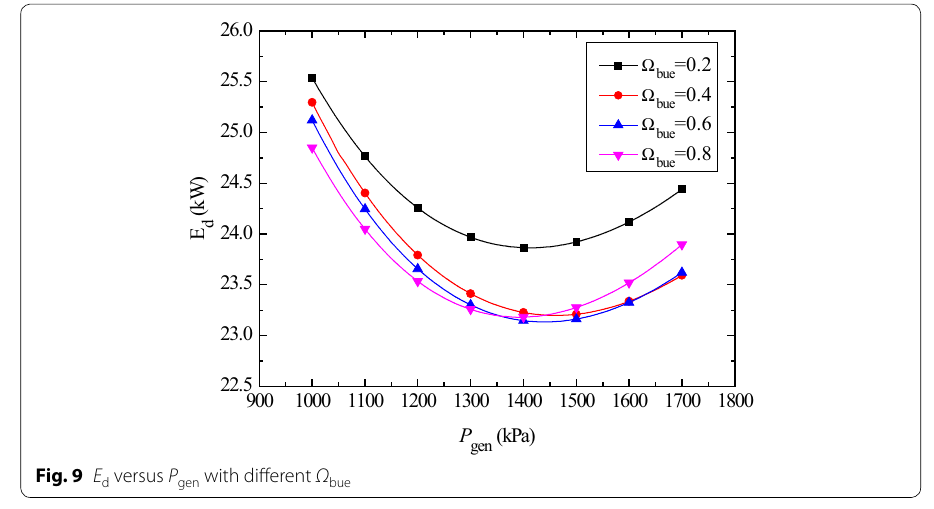
Fig. 9 E d versus P gen with different Ω bue